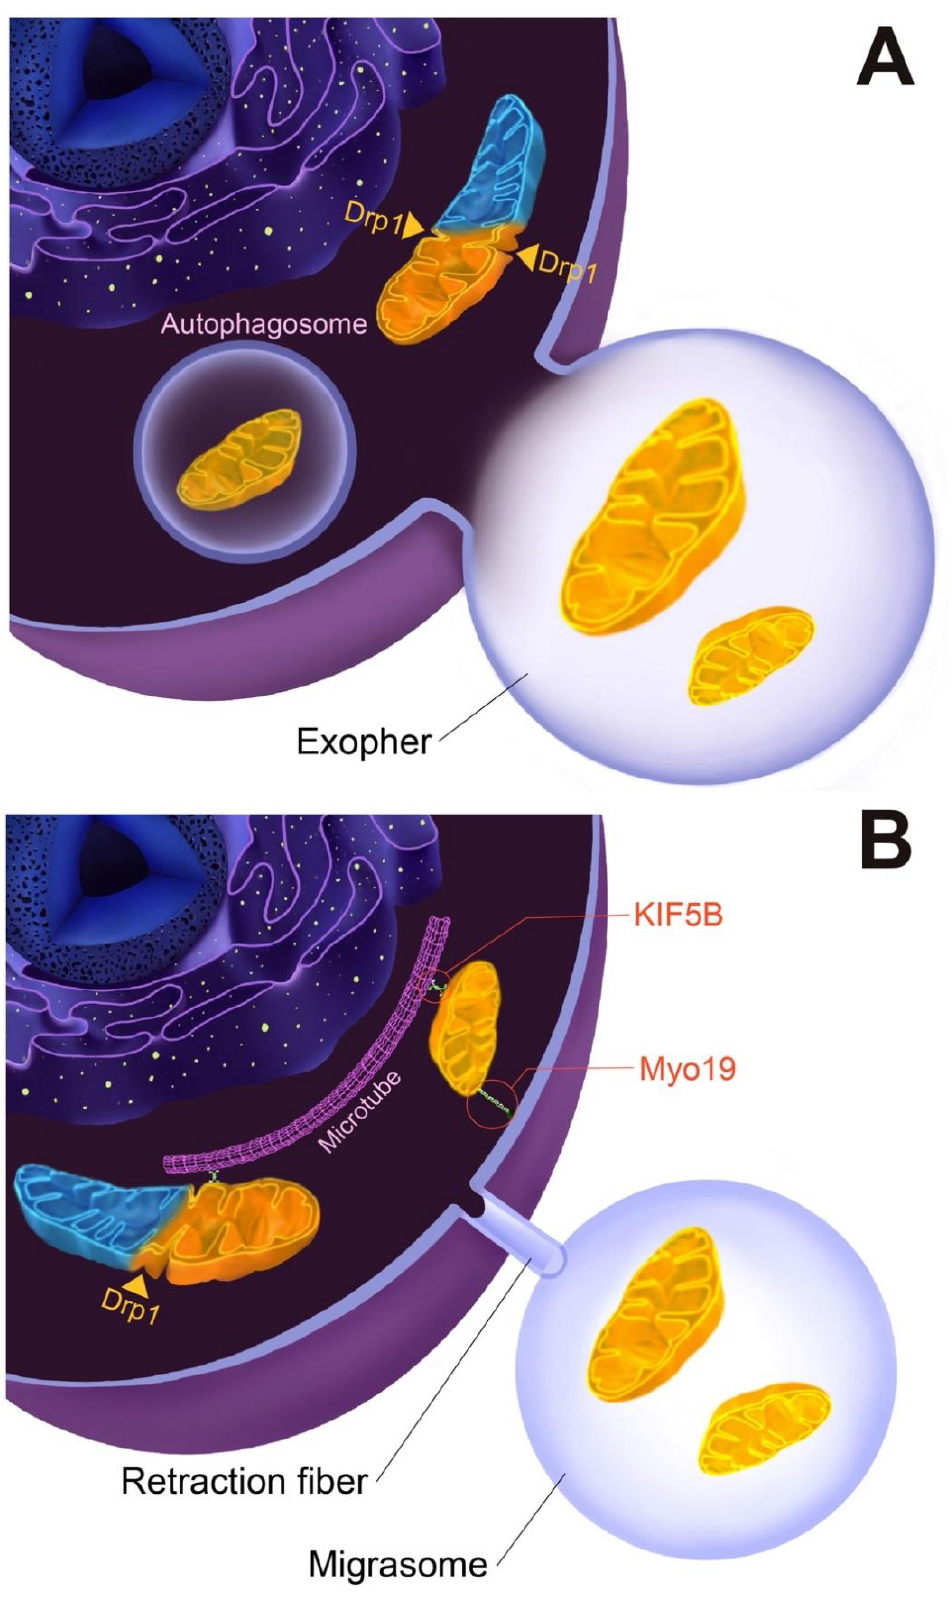
Figure 1. Schematic representations of mitochondrial disposal processes. ( A ) Exopher-mediated mitochondrial disposal process. ( B ) Mitocytosis, a migrasome-mediated mitochondrial disposal process. See text for details and definitions of abbreviations. Drp1: dynamin-related protein 1, KIF5B: kinesin family member 5B, Myo19: myosin XIX.